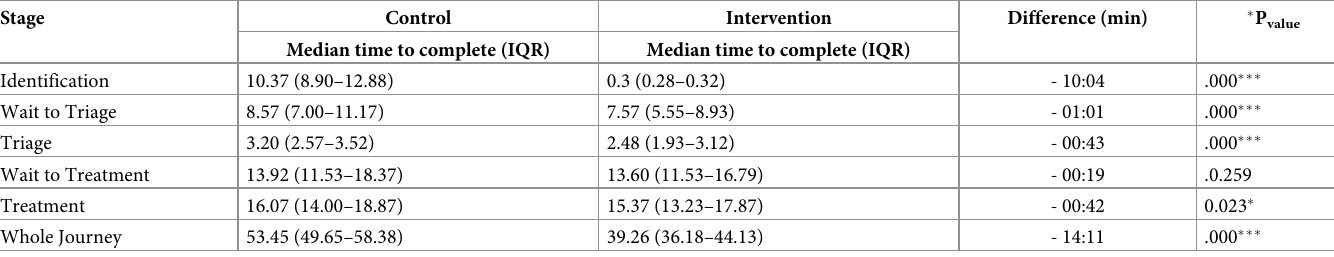
Table 7. Median time to complete–comparison.